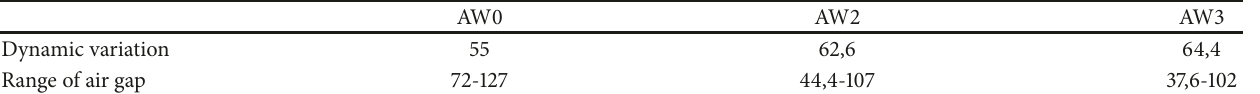
Table 1: Air gap fluctuation during movement.